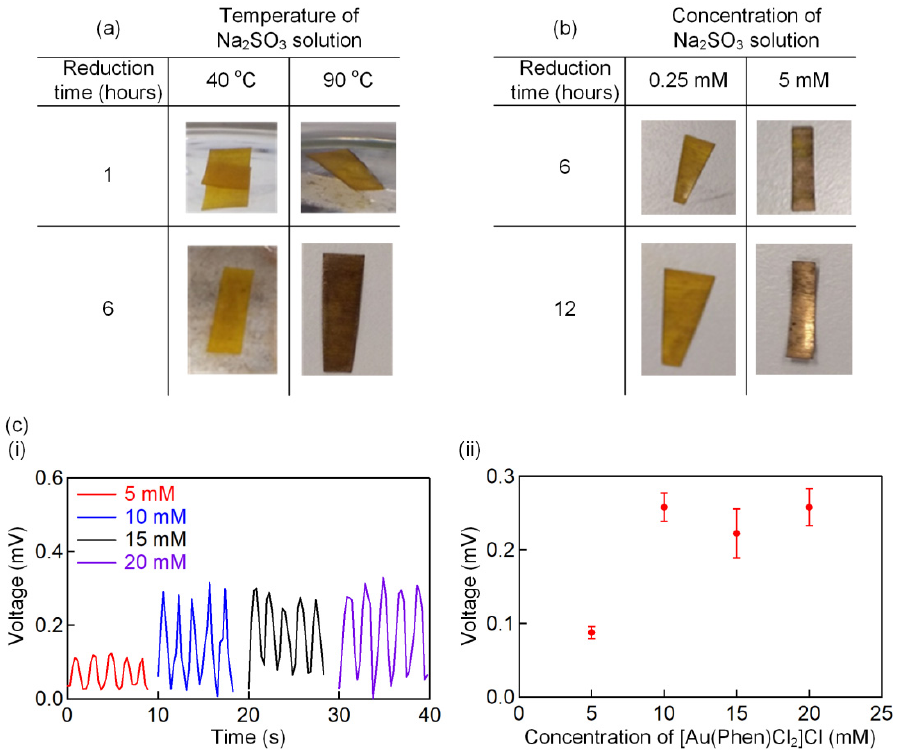
Figure 2. Photographs and illustrations of the ( a ) temperature and ( b ) concentration of the reducing agent, Na 2 SO 3 solution, on the gold electrode formation. ( c )( i ) Temporal response of the IPMC sensor for 5 repeated cycles with different concentrations of the [Au(Phen)Cl 2 ]Cl solution. ( c )( ii ) The steady-state output voltage behavior as a function of the concentration of the [Au(Phen)Cl 2 ]Cl solution.